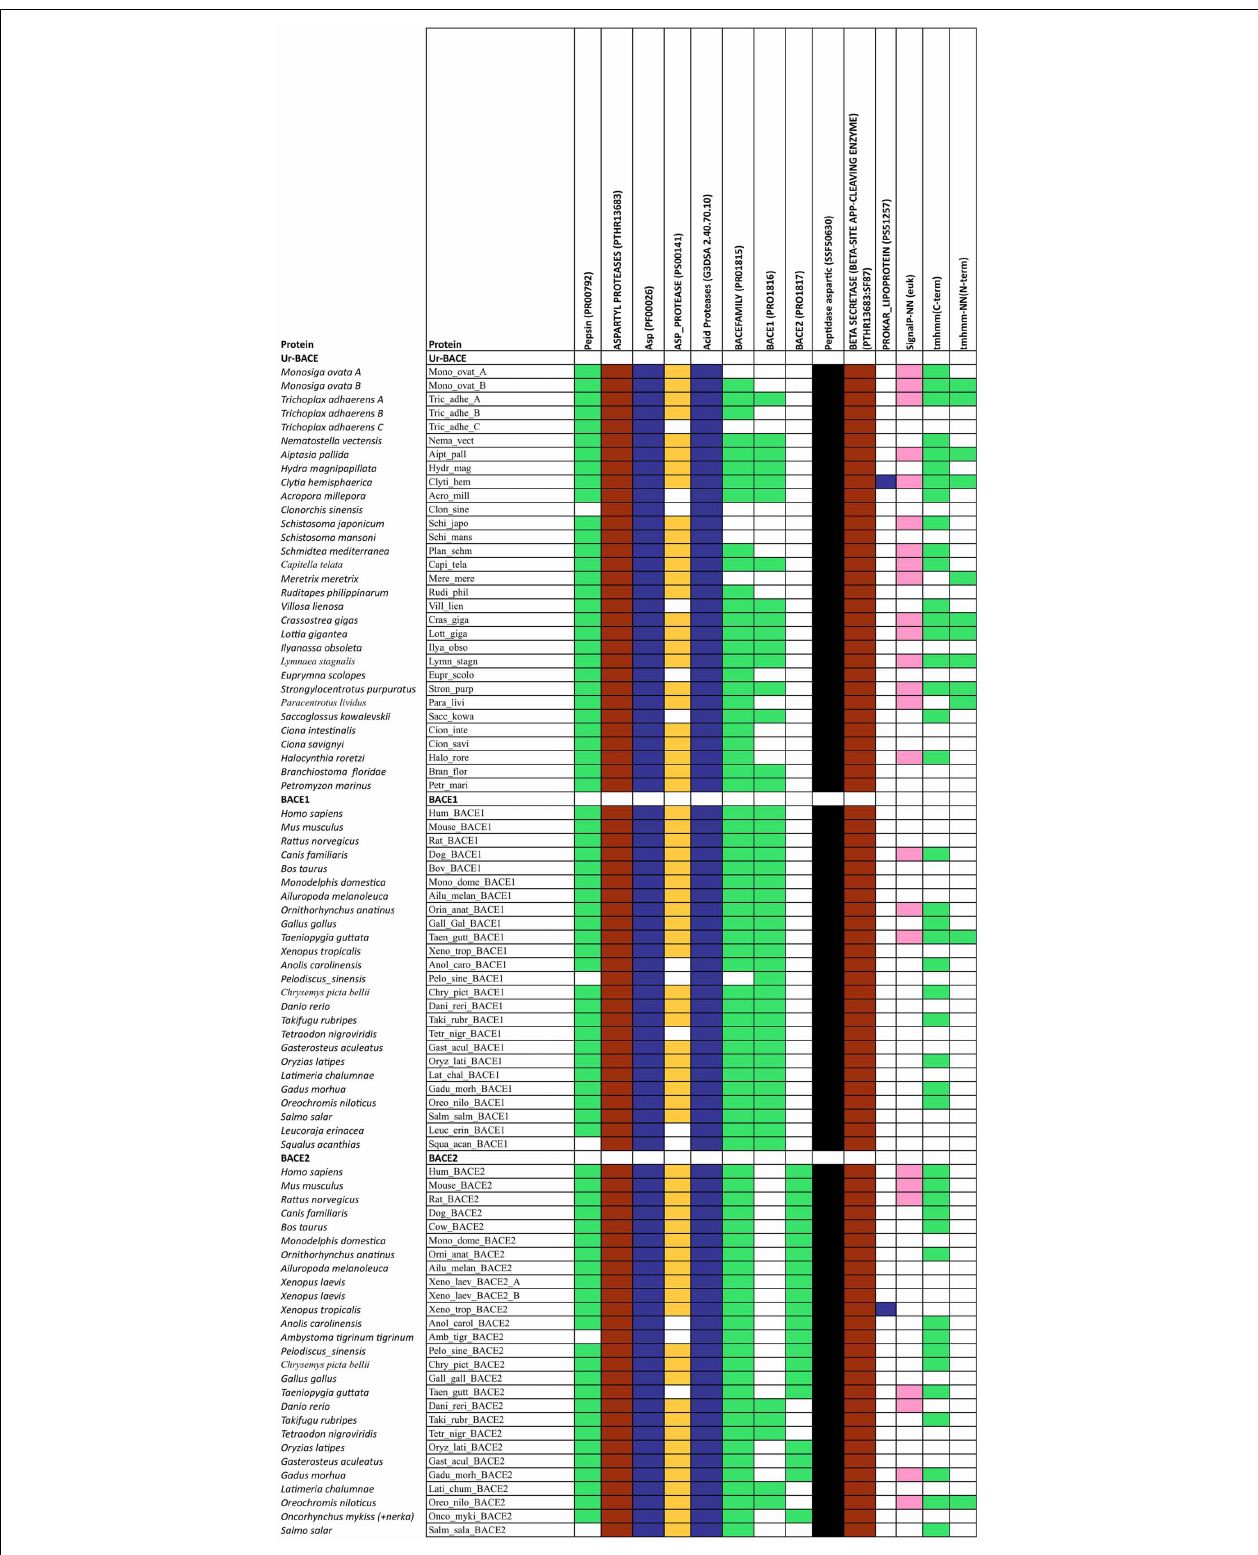
FIGURE 2 | Summary of InterProScan pattern hits for the proteins included in Table 2.